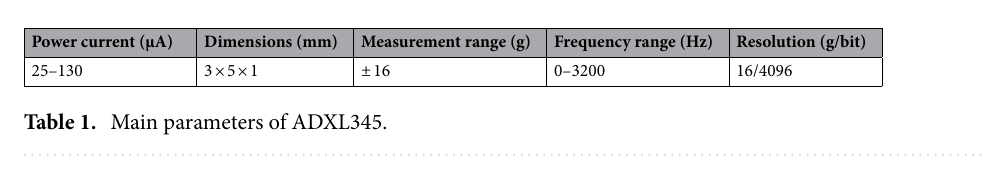
Figure 2. Configured components of the sensor system.